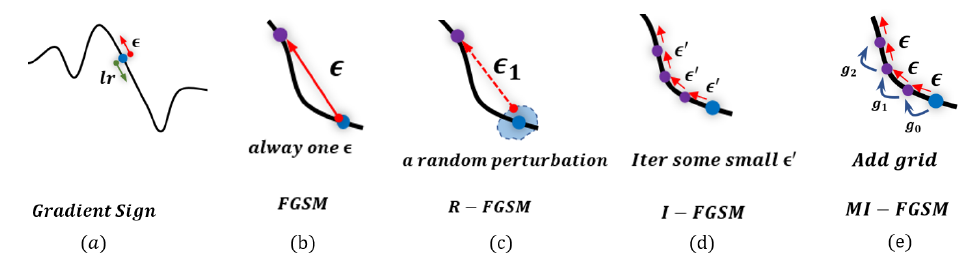
Figure 5. Gradient-based adversarial example generation algorithms. Figure ( a ) denotes the the gradient direction of the model training and adversarial updating. Figure ( b ) shows a single-step attack, and Figure ( c ) precedes the single-step attack with a random perturbation. Figure ( d ) shows a typical multi-step iterative attack, taking one small step in each step, and in figure ( e ), momentum is accumulated at each iteration